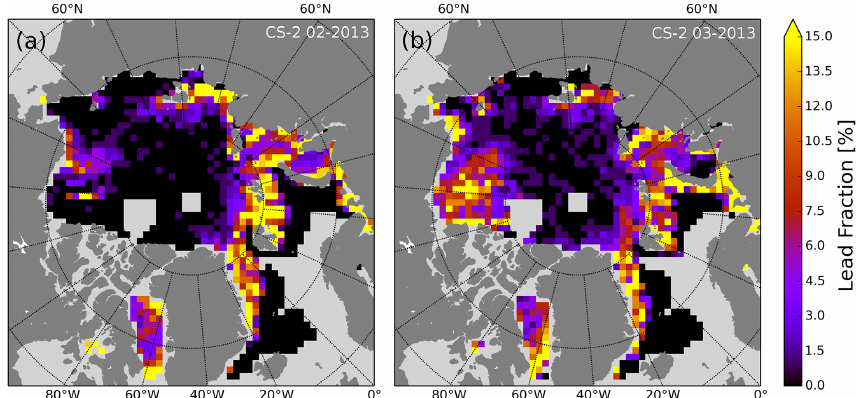
Figure 9. Lead fraction derived from CS-2 SAR mode on a north polar stereographic grid with a resolution of 99 . 5km × 99 . 5km from February (a) and March 2013 (b) . Only lead fraction values north of 65 ◦ N based on at least 1000 measurements are shown. Missing estimates north of Canada are caused by the use of the SARIn mode in the Wingham